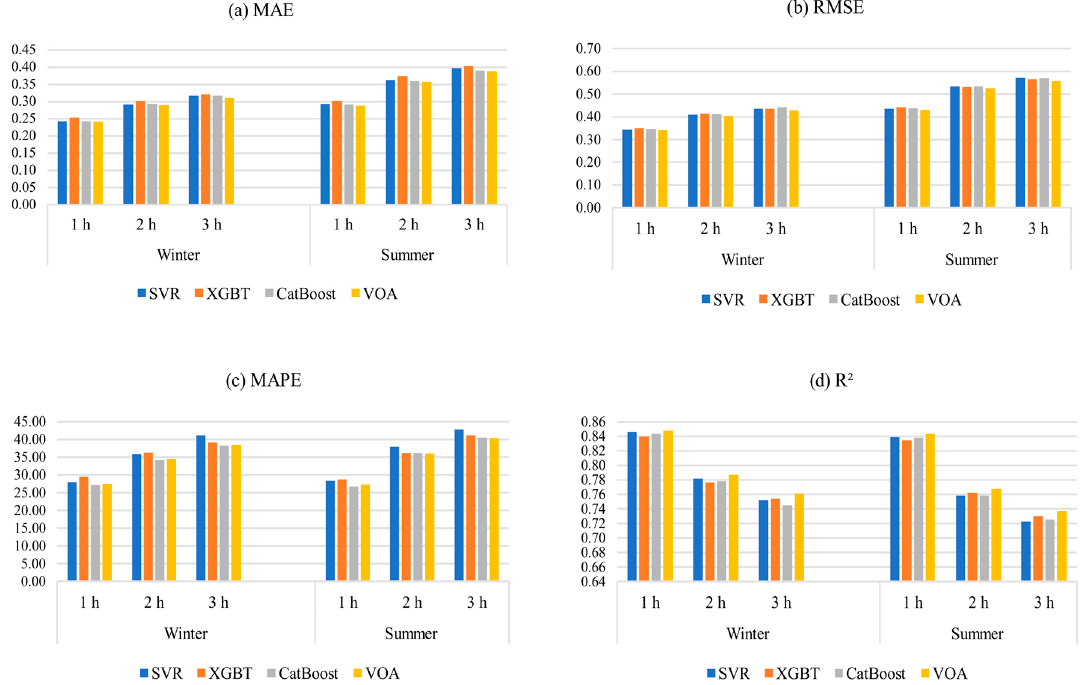
Figure 10. Performance of ML algorithms for different prediction time horizons: ( a ) MAE, ( b ) RMSE, ( c ) MAPE, ( d ) R 2 .